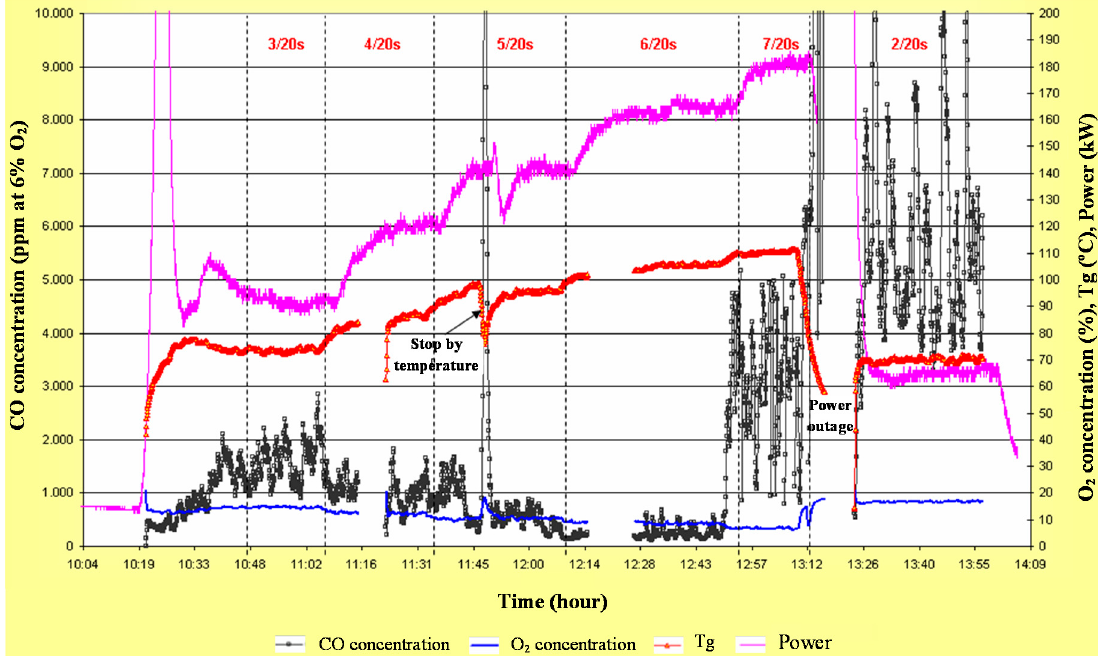
Figure 2. Evolution of CO emissions corrected to 6% O 2 , O 2 concentration, exhaust gas temperature (Tg), and power during combustion tests with pellets from olive tree.